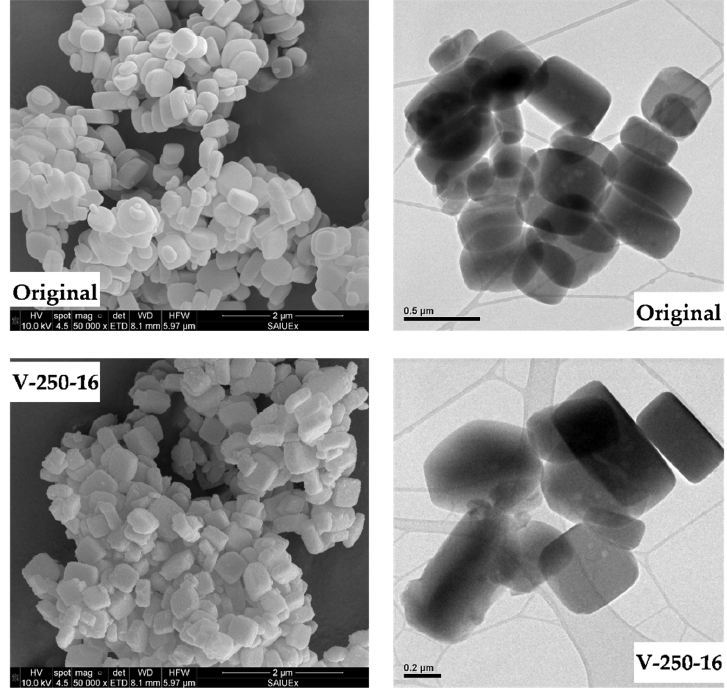
Figure 3. Scanning electron microscopy (SEM) and transmission electron microscopy (TEM) images of the original NH 2 -MIL-125(Ti) and V-250-16 sample. the original NH 2 -MIL-125(Ti) and V-250-16